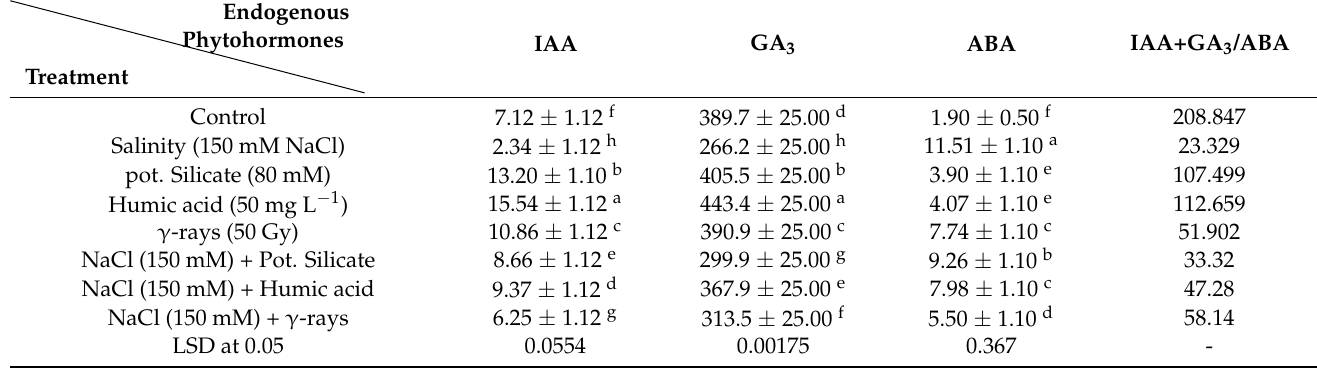
Table 5. Influence of biostimulants’ pretreatments on endogenous phytohormones ( µ g/100 g F. wt.) at flowering stage of coriander plants under salinity stress. Control and salinized stressed coriander samples were subjected to 80 mM pot. silicate, 50 mg L − 1 HA or soaked in water after exposure by 50 Gy γ -rays. Based on Duncan’s multiple range test, the different alphabetical letters express significant variation (defined as p <